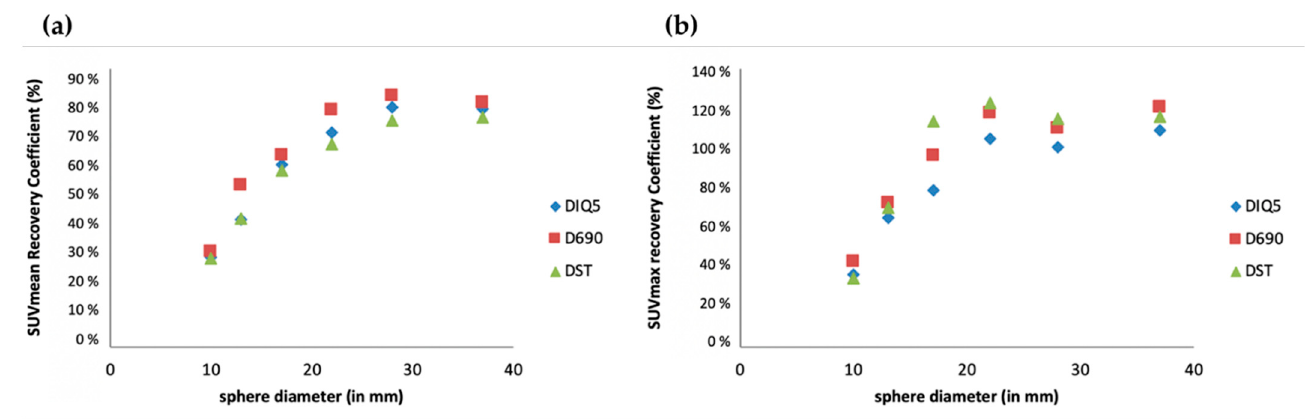
Figure 2. Semiquantitative assessment (SUV mean ( a ) and SUV max ( b )) of [ 18 F]FDG PET images obtained with three PET/CT systems (GE Healthcare USA, Inc.): Discovery ST (DST), Discovery 690 (D690) and Discovery IQ5 (DIQ5).